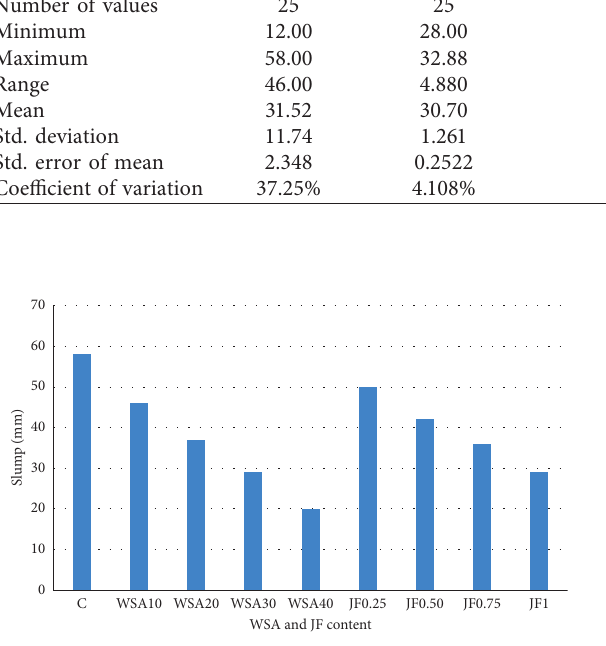
Figure 2: Workability of mixtures containing WSA and jute fiber.